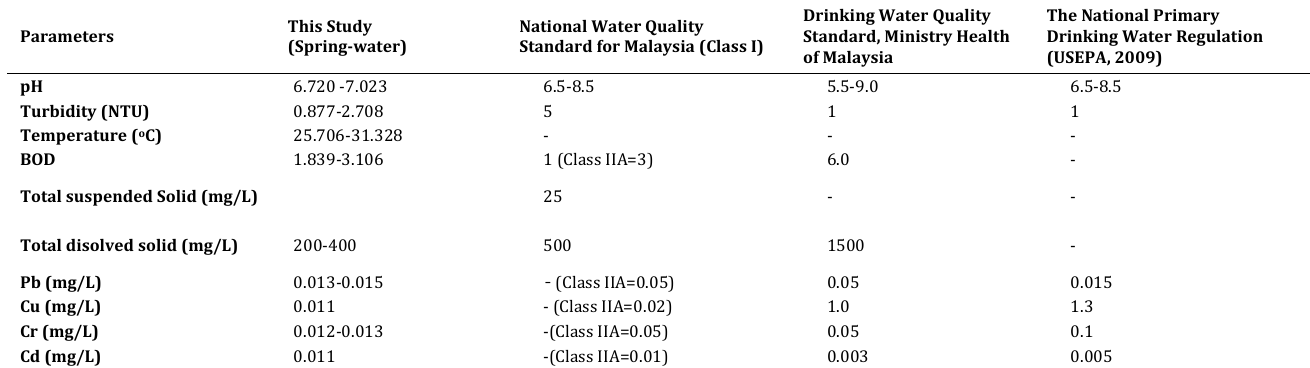
Table 7: The water quality standard and drinking water